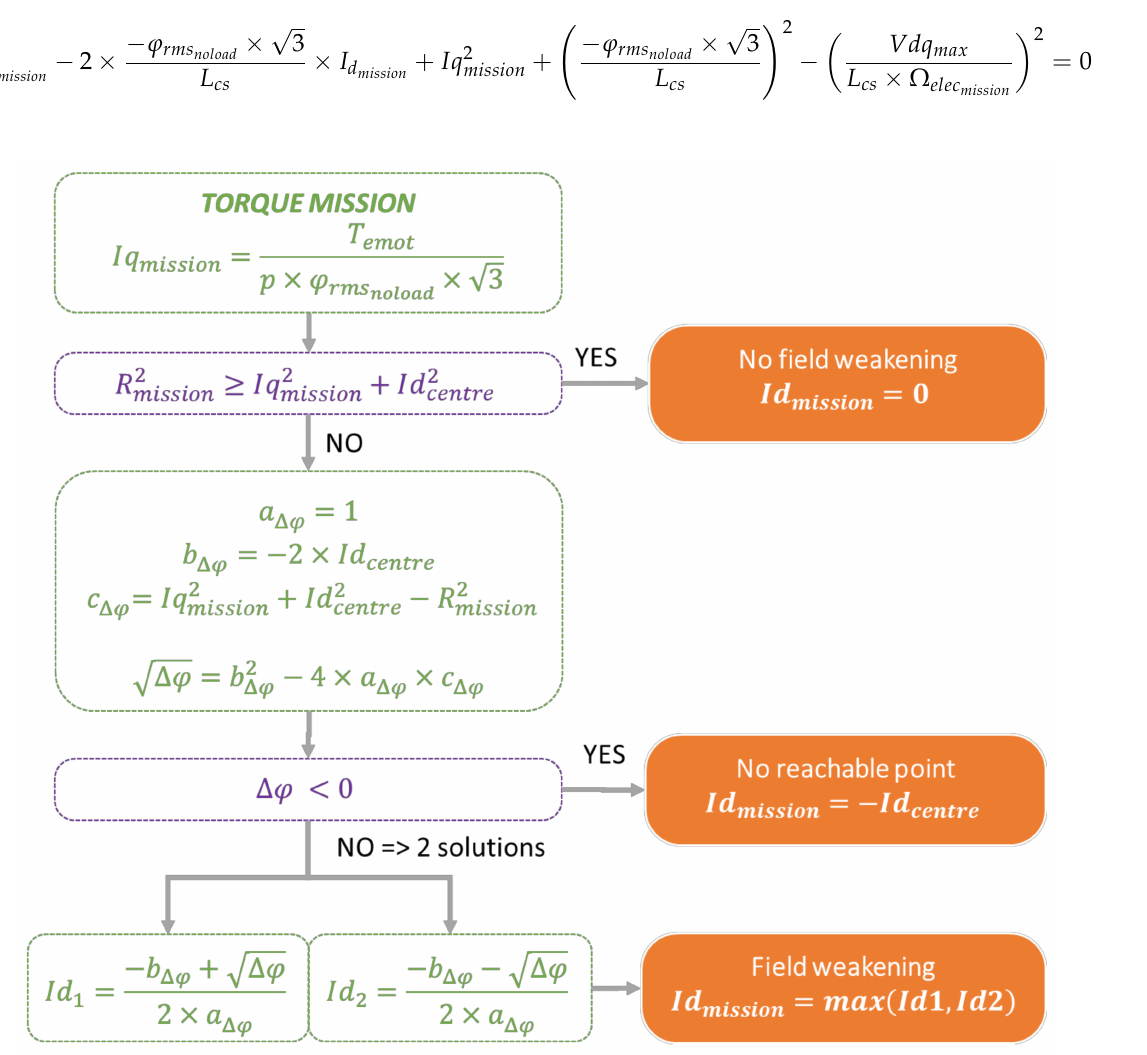
Figure 8. Actuator control